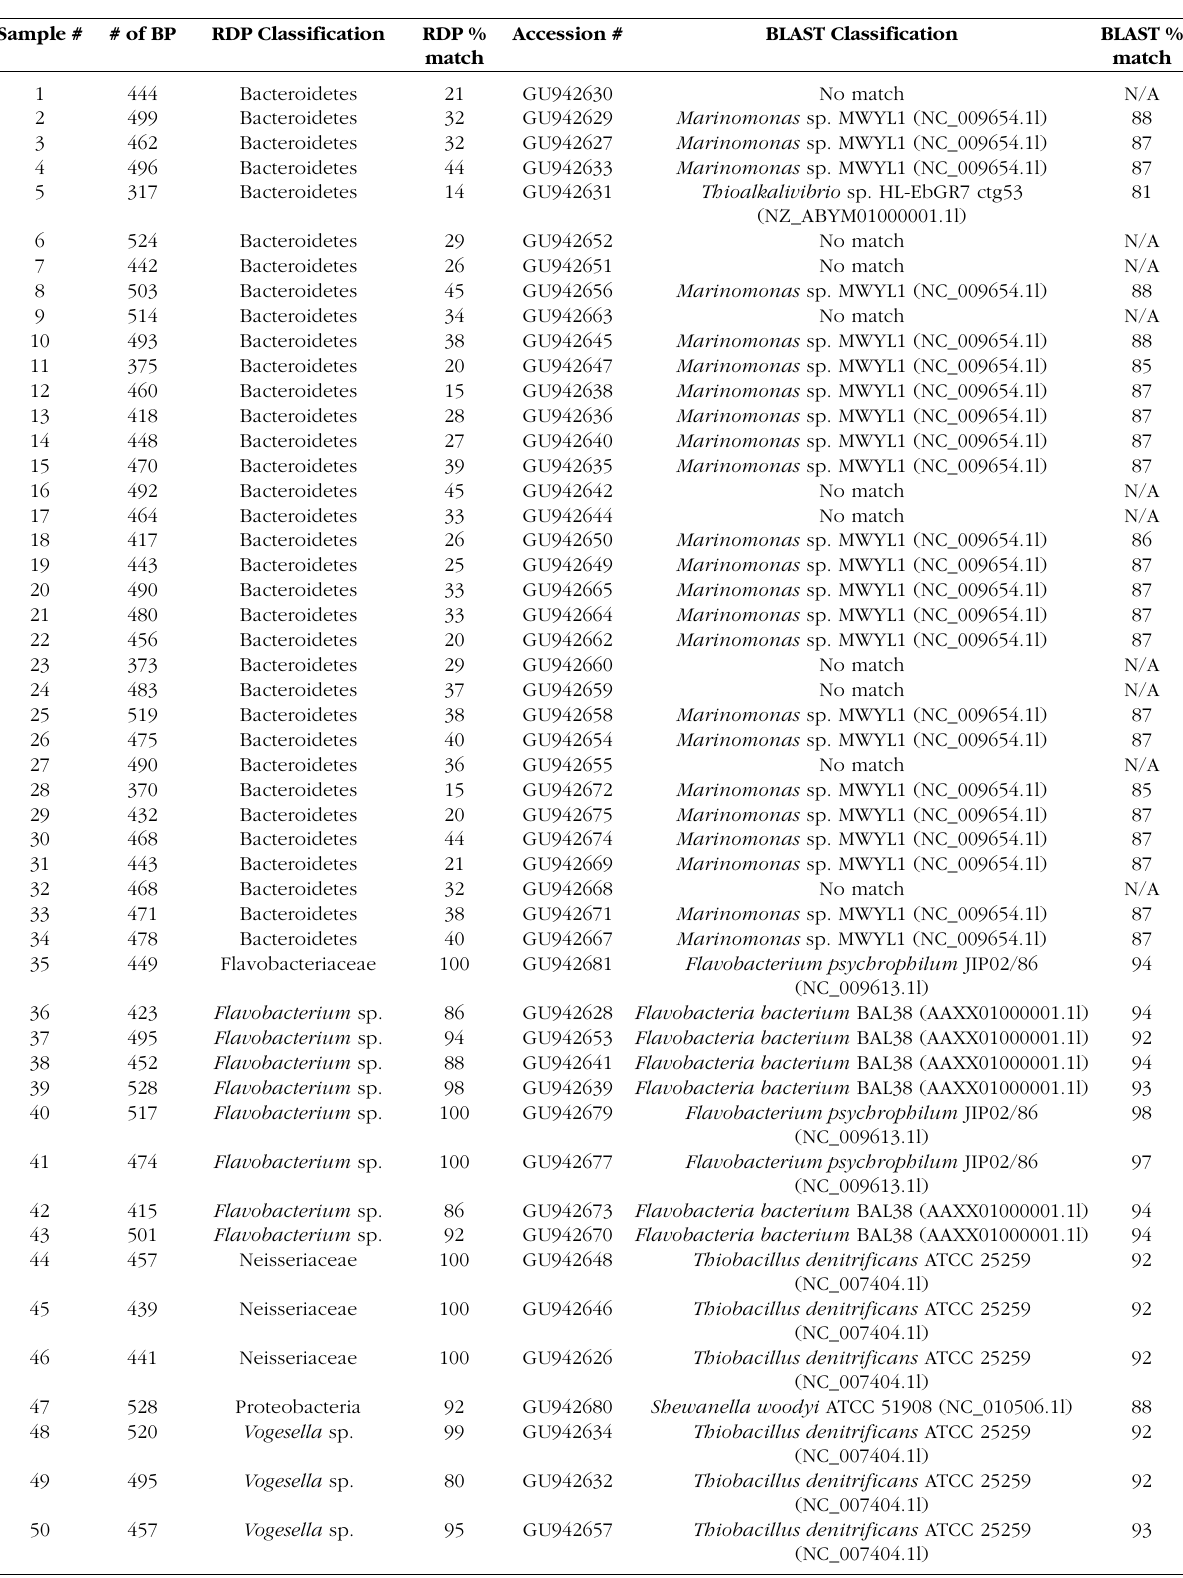
Table ii. – Sequence classification for each sample in the study - classification was first determined according to the RDP, followed by classification according to BlaST. Sample numbers 1-55 are from channel catfish tissue homogenate, whereas samples 56-113 are from freshwater drum tissue